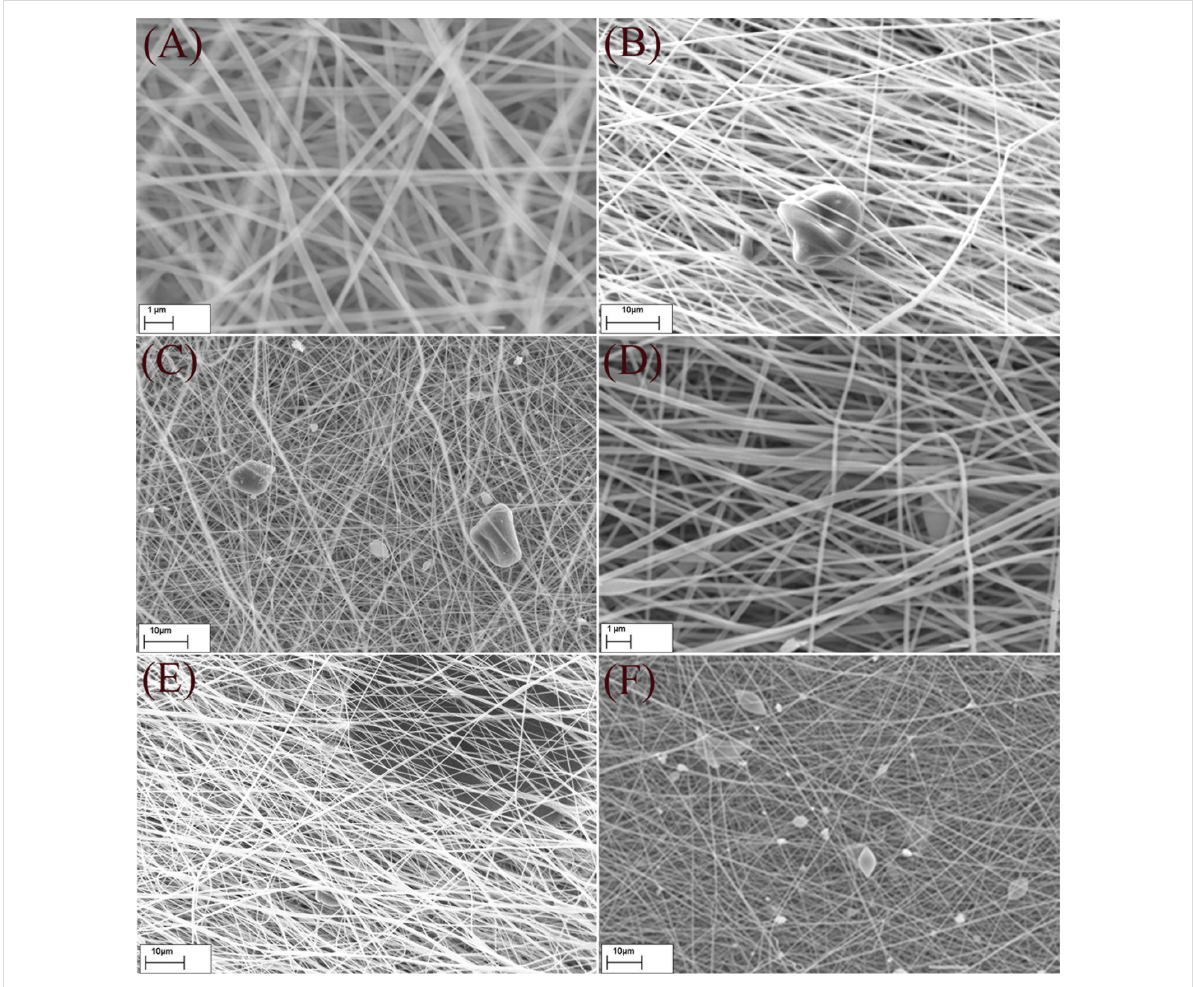
Figure 2: SEM micrographs of NFMs, A) smooth and randomly oriented fibers in NFM-0%, B & C) entrapment of biochar among fibers in NFM-0.5% and NFM-1%, D & E) NFM-1.5% at different magnifications and F) formation of beads in NFM-2%.